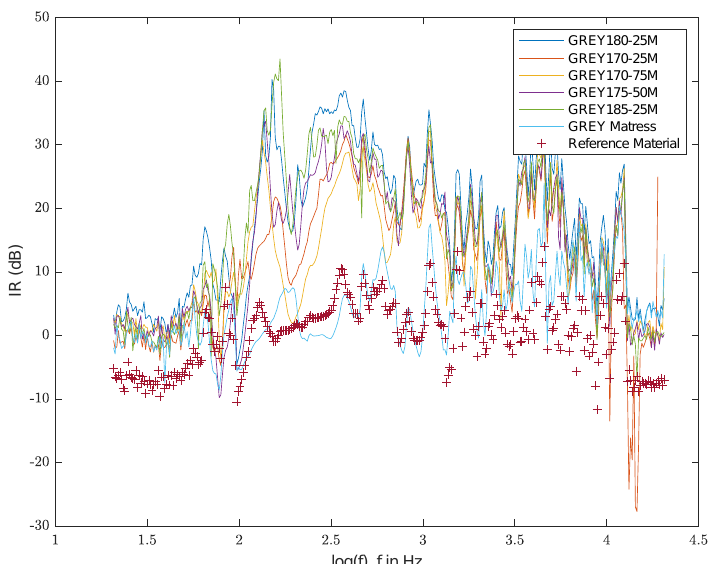
Figure 9. Reduction index of grey briquettes (lines) compared to the reference material (crosses). Volume 4.